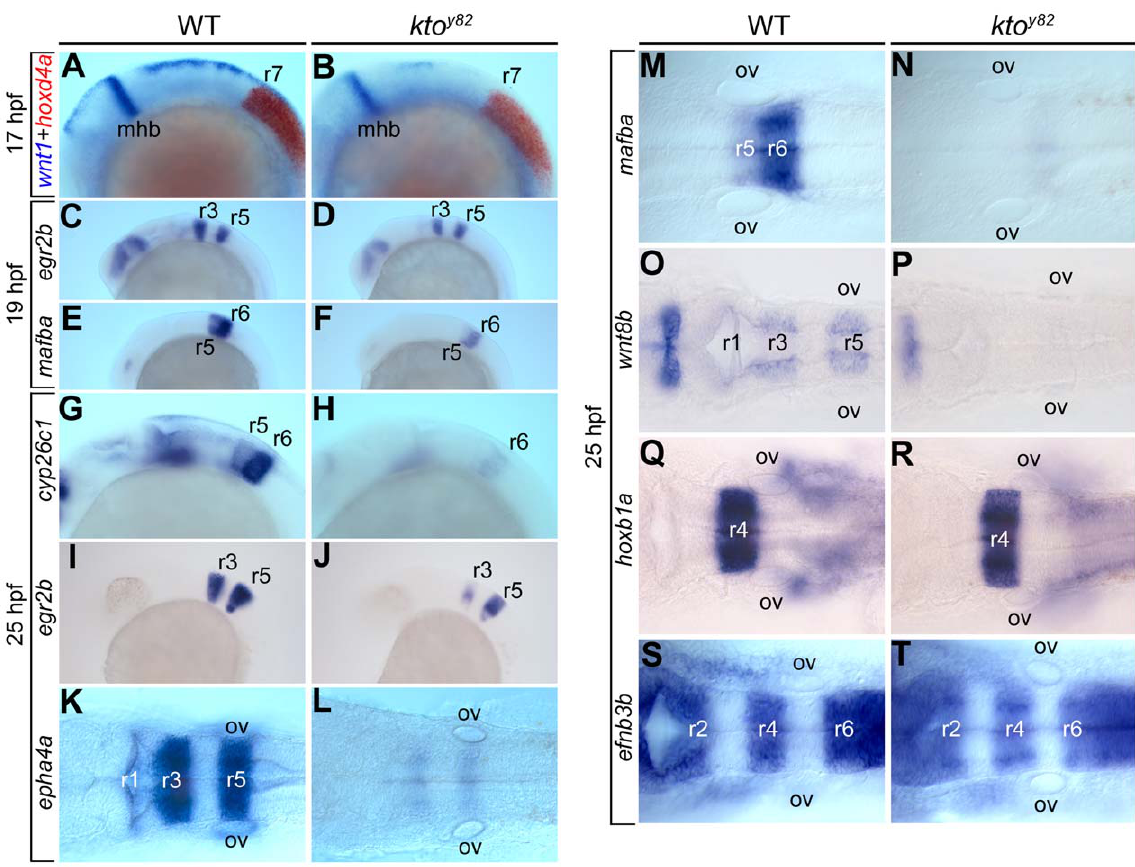
Figure 2. Hindbrain segmentation in the kto y82 mutant. Lateral (A–J) and dorsal views (K–T) of wt and mutant embryos, as indicated, stained by whole mount in situ hybridization. Two-color in situ hybridization with wnt1 (blue) and hoxd4a (red) at 17 hpf (A,B). Expression of egr2b (C,D) and mafba (E,F) at 19 hpf, and cyp26c1 , egr2b , epha4a , mafba , wnt8b , hoxb1a and efnb3b at 25 hpf (G–T). mhb, mid-hindbrain boundary; ov, otic vesicle; r, rhombomere.